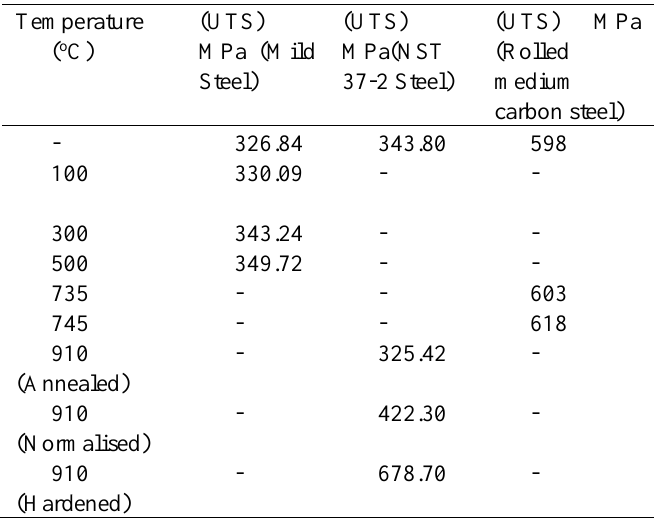
Compared tensile strength